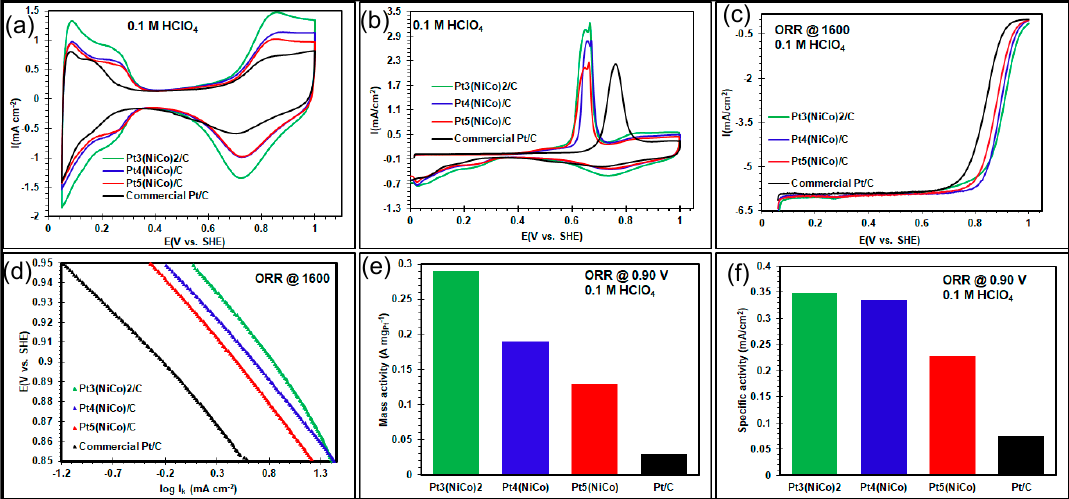
Figure 5. Pt 3 (NiCo) 2 /C, Pt 4 (NiCo)/C, Pt 5 (NiCo)/C and commercial Pt/C electrocatalysts: ( a ) cyclic voltammograms; ( b ) CO-stripping voltammetry; ( c ) ORR polarization curves; ( d ) the corresponding Tafel plots; ( e ) mass-specific activities; and ( f ) intrinsic area-specific activities at +0.9